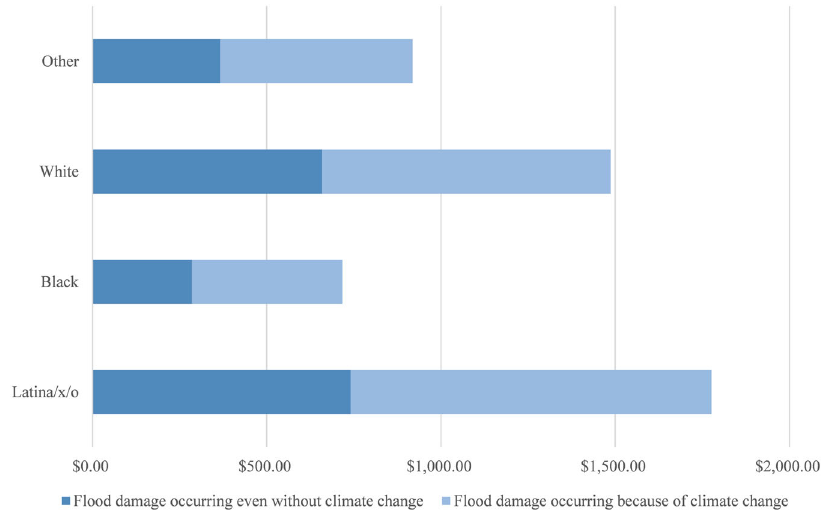
Fig. 3 Estimated per capita property damage from fl ooding by racial composition (38% scenario). Estimated per capita damages for residential properties in Harris County, TX during Hurricane Harvey.